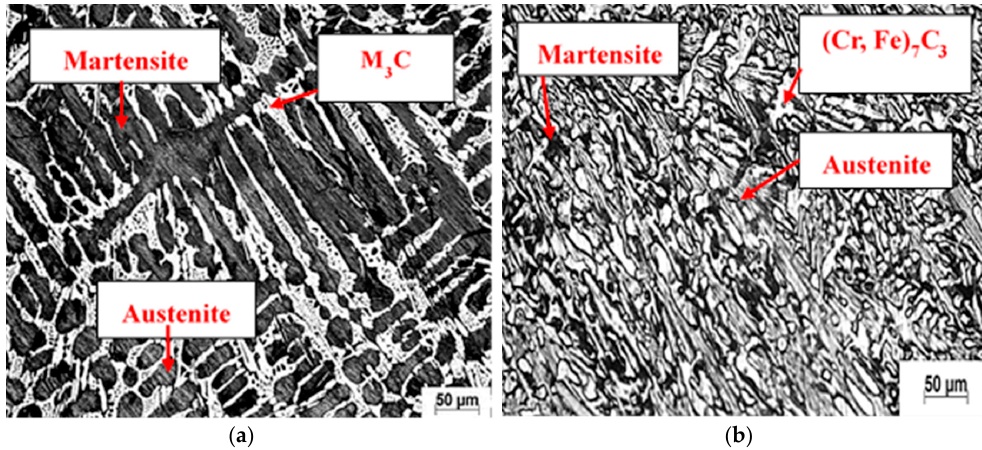
Figure 2. Optical microstructure of the as-cast ( a ) S1 (Ni-hard 1) sample ( b ) S2 (Ni-hard 4) sample.